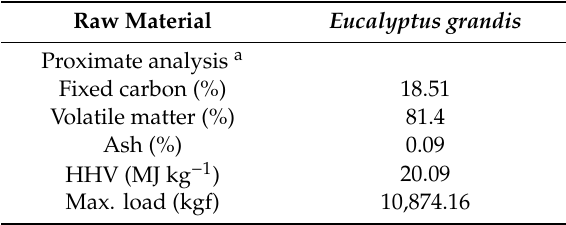
Table 1. Proximate, calorific, and compression strength analyses of Eucalyptus grandis .